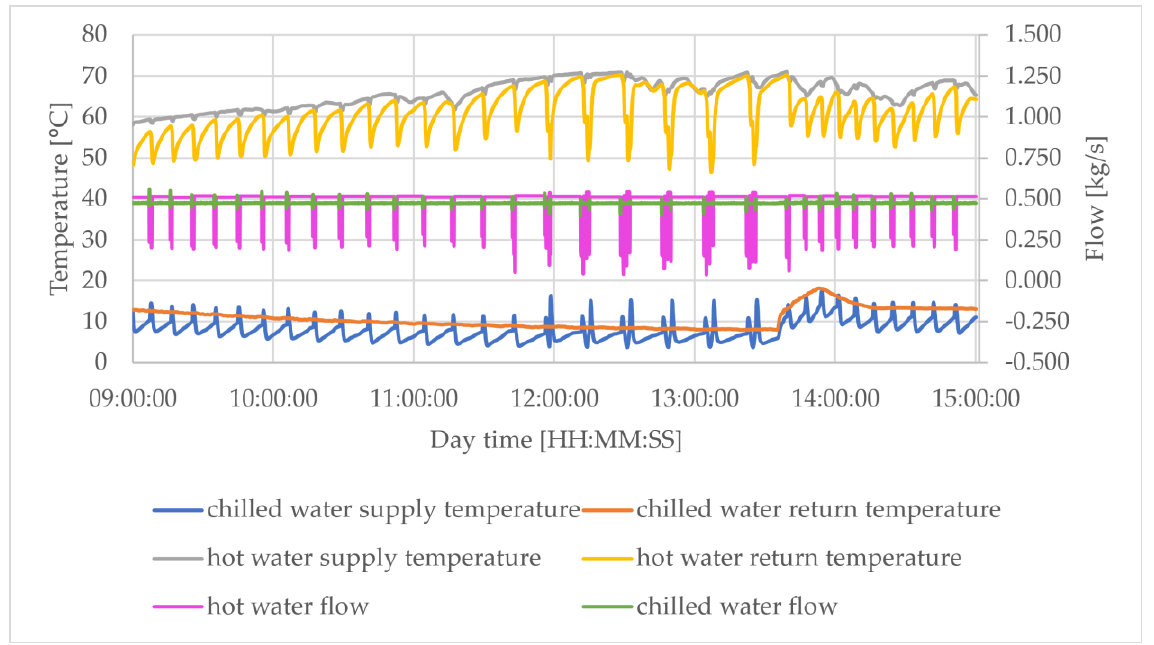
Figure 9. Measured values of temperatures and flow rates over time for 8th July.